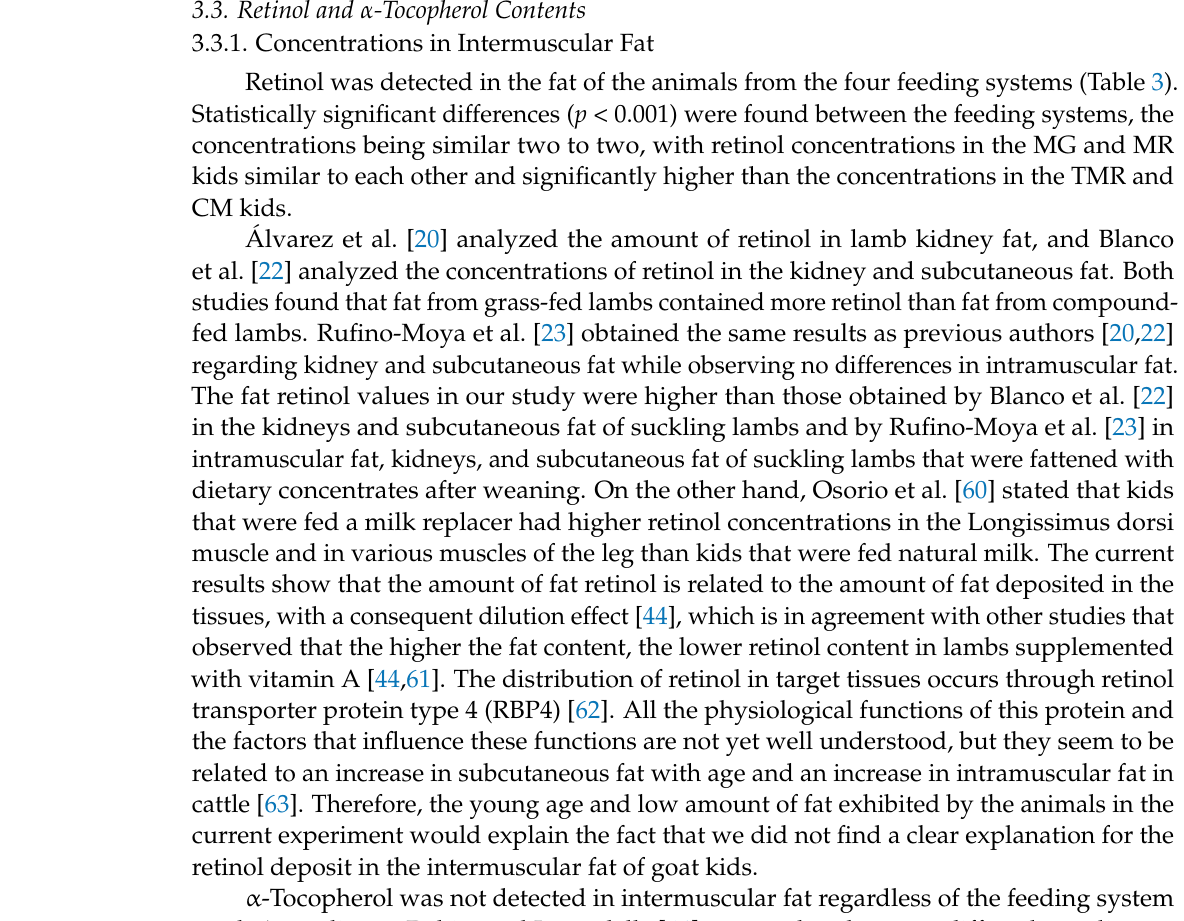
Table 3. The mean, standard error, and p -value (ANOVA) of the effect of the feeding system on the percentage of intramuscular fat, the lipid oxidation index (mg MDA/kg of meat), and the concentrations of retinol and α -tocopherol in the plasma ( µ g/mL) and intramuscular fat ( µ g/g) of the Longissimus thoracis muscle in kids reared under four different feeding systems. Natural Milk Milk Replacer MG CM TMR MR p -Value % LTF 1.13 a ± 0.13 4.90 b ± 0.48 4.81 b ± 0.53 1.63 a ± 0.21 <0.001 MDA 0.089 a ± 0.011 <0.001 Fat Retinol Plasma